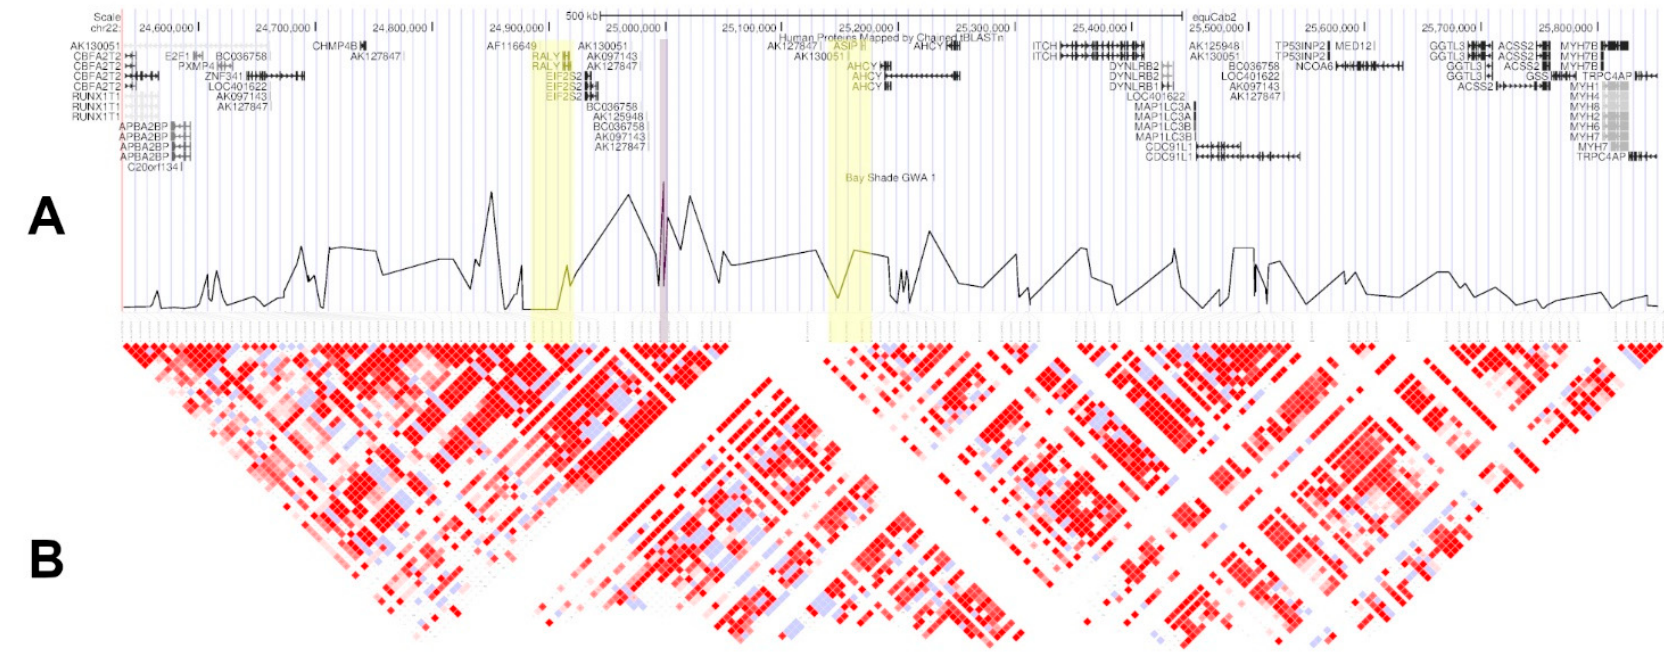
Figure 3. The GWAS-identified candidate region chr22:24,535,302–25,851,386. ( A ) Orthologous human proteins (top) and SNP p- values plotted by position (bottom); the best marker from GWAS is highlighted in purple, and the two functional candidate genes ASIP and RALY in yellow. ( B ) Haploview plot of pairwise LD between SNPs. Relationships where logarithm of odds (LOD) ≥ 2 and D’ = 1 are shaded in red.